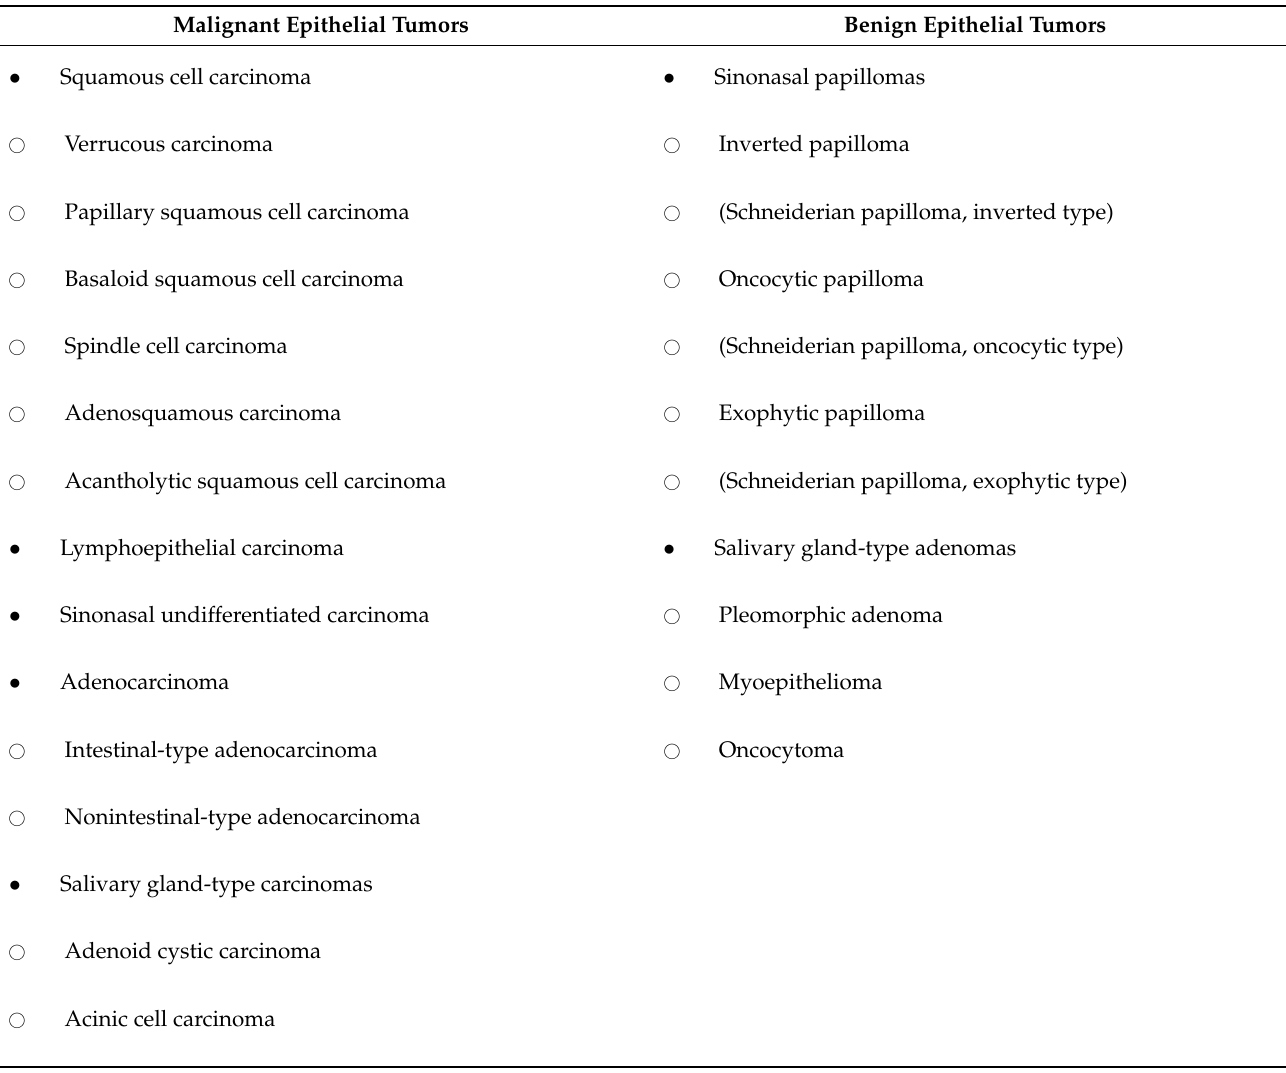
Table 2. Sinonasal neuroendocrine tumor